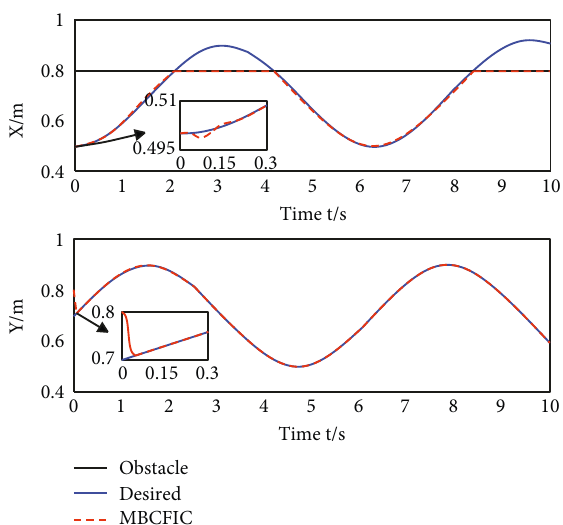
Figure 4: Position tracking curve (the command filtering method).